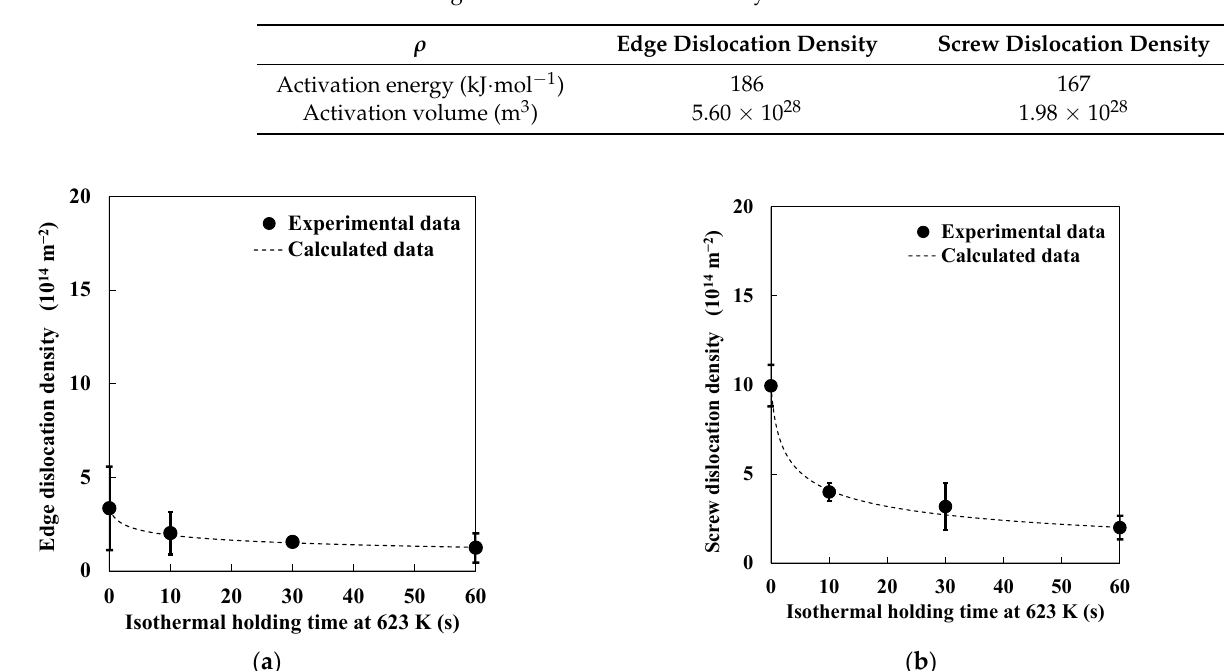
Figure 8. Changes in ( a ) edge- and ( b ) screw-dislocation densities during isothermal holding at 623 K, estimated by X-ray diffraction line profile analysis and the newly developed model.